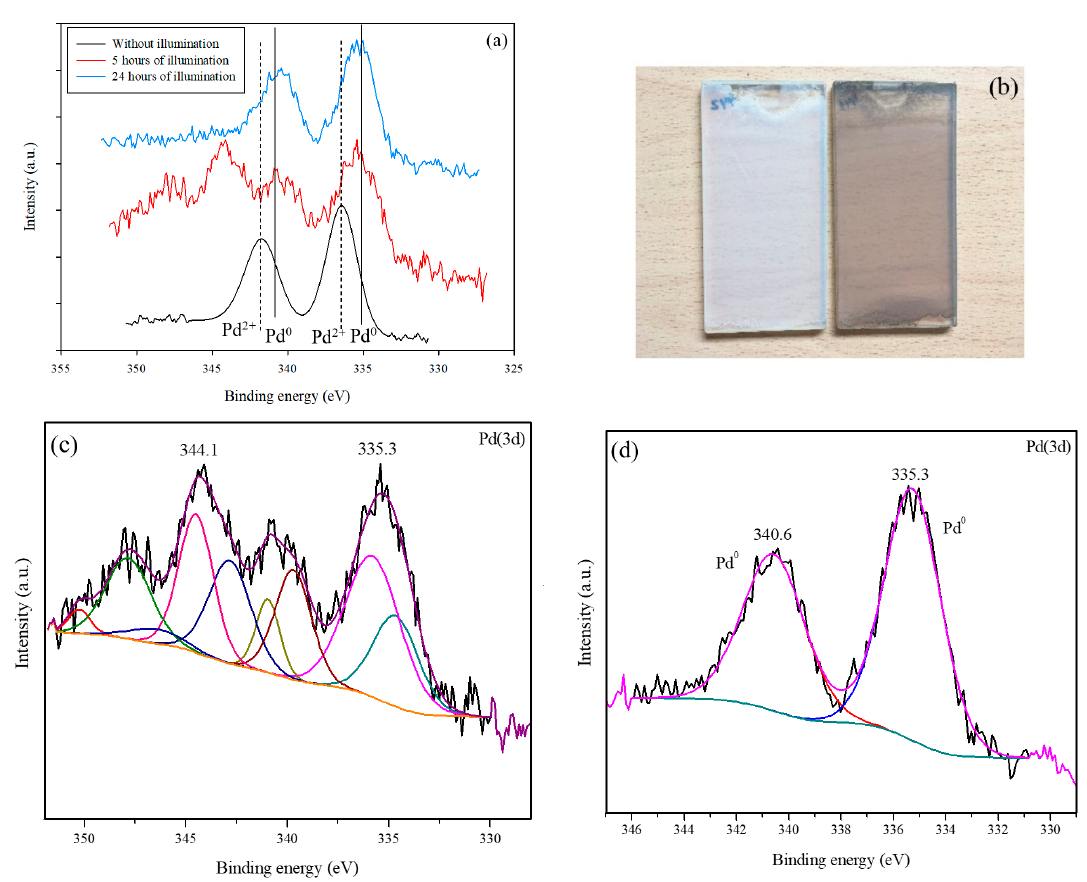
Figure 10. XPS spectra corresponding to the 3d region of the Pd-I: comparison at different exposure times ( a ) and deconvolution at 5 h ( c ) and 24 h of illumination ( d ). Appearance of the coatings of initial Pd-I and Pd-I after 24 h ( b ).